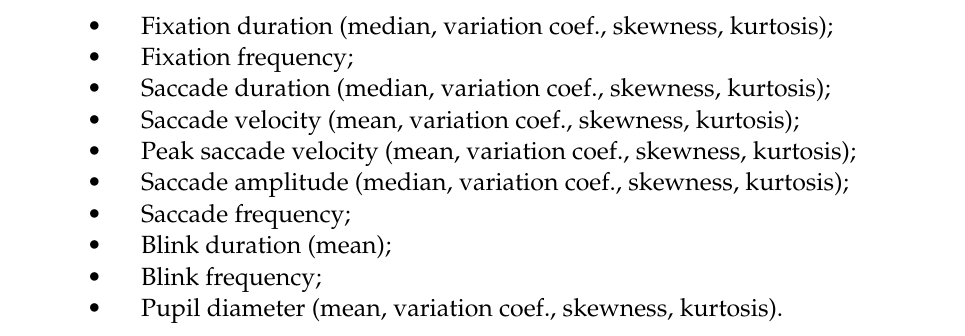
Table 2. Estimated mean values ± standard errors of all features for three classes of EA and EV. EA EV